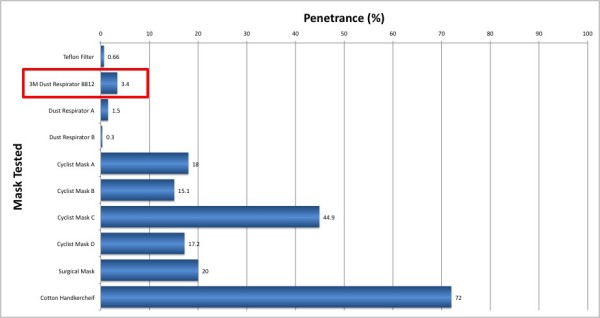
Penetrance of commercially available filters: 3 M Dust Respirator 8812, Dust Respirators A and B, Cyclist Masks A to D. The Teflon filter is an industry standard filter for aerosol studies included as a control. Cotton handkerchiefs and surgical masks are often seen worn in public areas in parts of Asia.